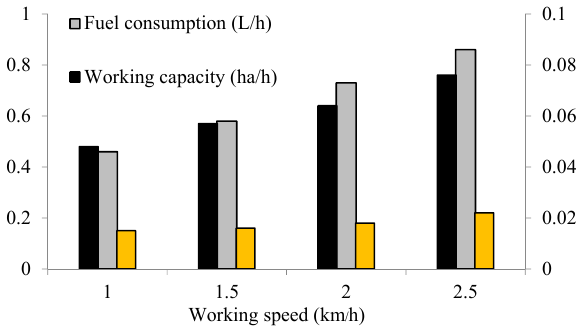
Figure 6. Variable sprayer system field performance.